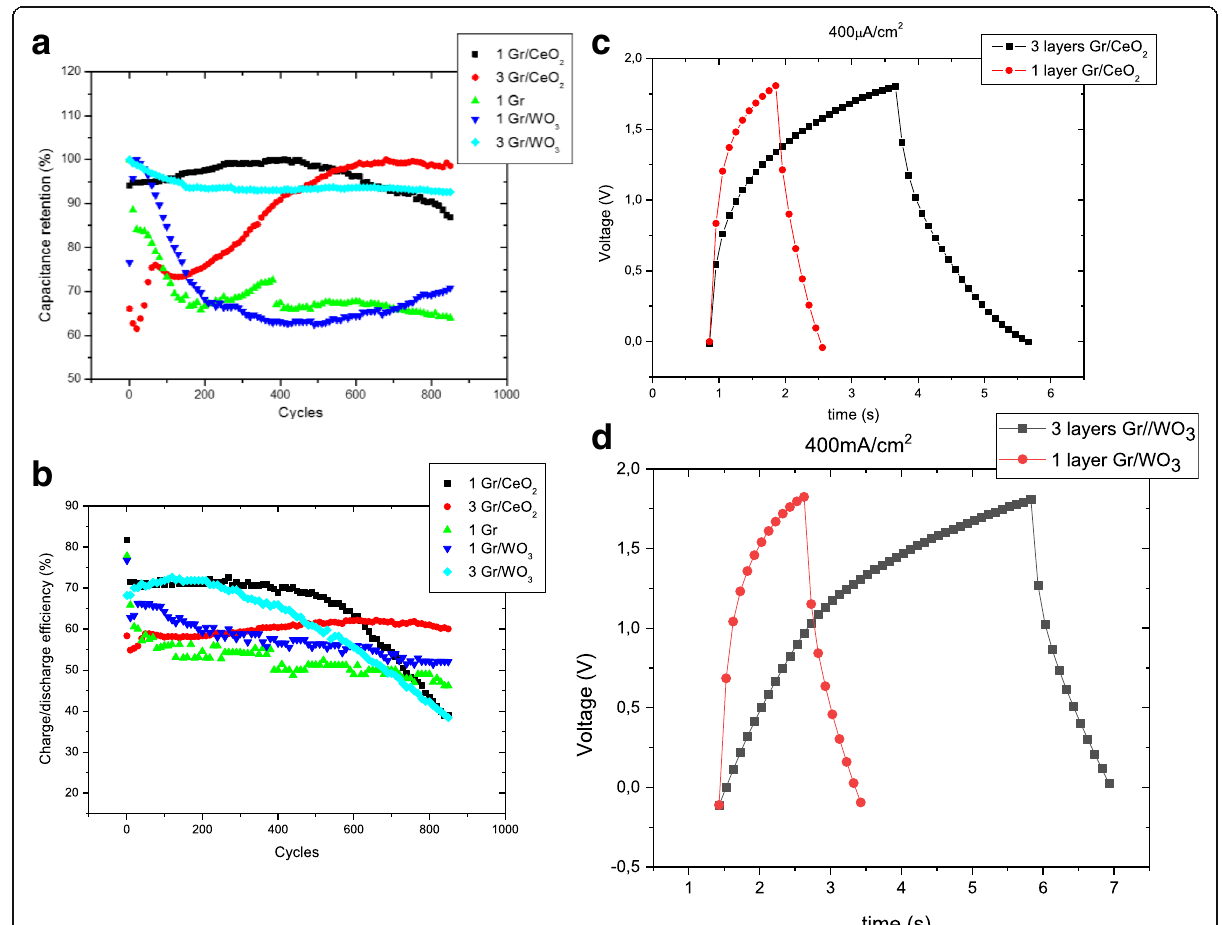
Fig. 6 Electrode efficiency. Detailed legend: a Capacitance retention of the different electrodes and b charge/discharge efficiency. c Charge-discharge cycle of one and three layers of Gr/CeO x . d Similar for the Gr/WO 3 hybrid